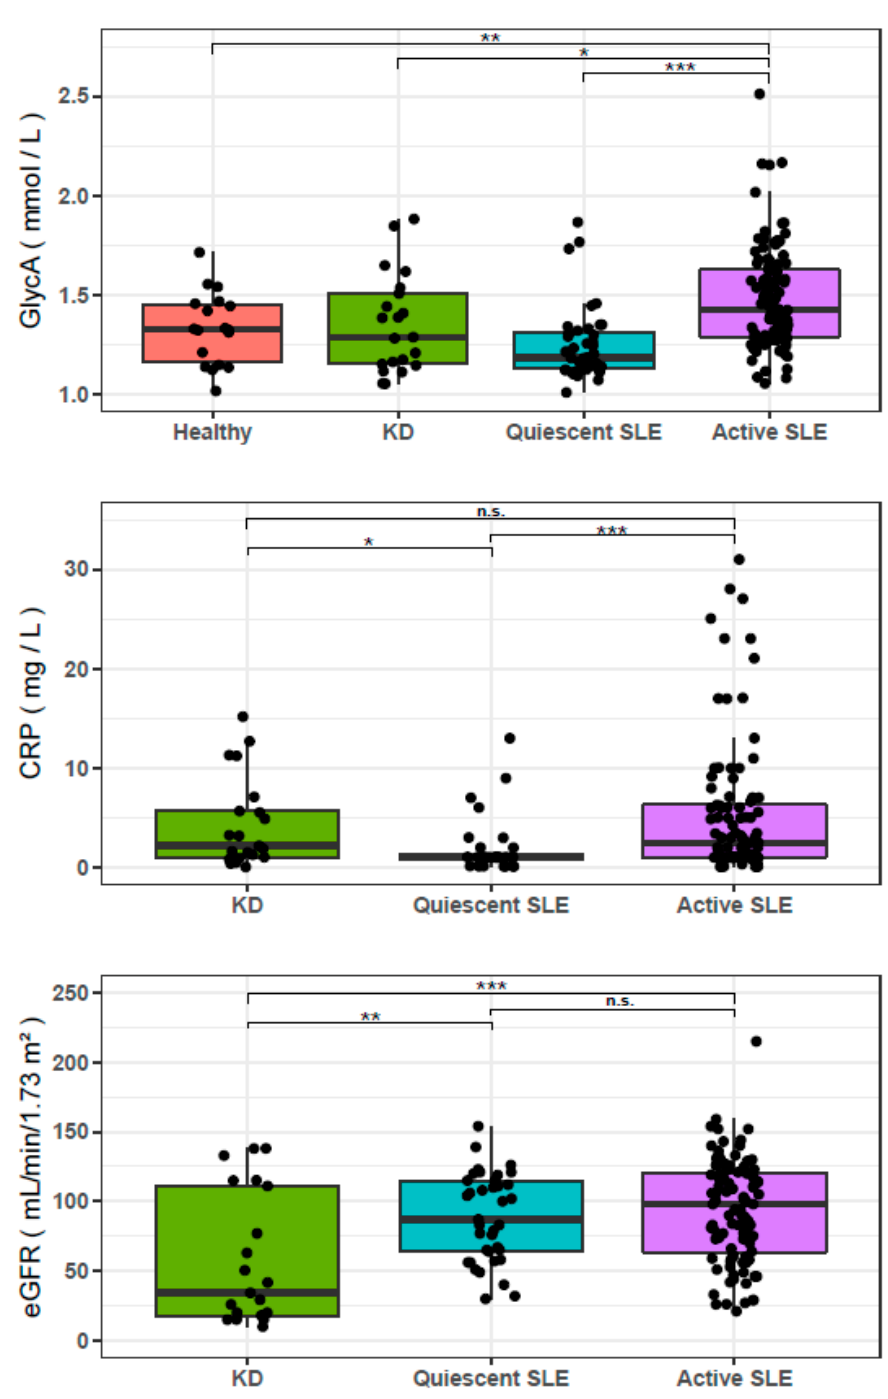
Figure 1. Glycoprotein Acetylation (GlycA), CRP and eGFR of healthy controls, kidney disease controls (KD), quiescent Systemic Lupus Erythematosus (SLE) and active SLE. GlycA is elevated in active SLE ( n = 105), compared to healthy controls ( n = 20), KD controls ( n = 21), and quiescent SLE ( n = 39) patients. CRP level is lower in quiescent SLE than in active SLE and KD controls but does not di ff er between active SLE and KD controls. Estimated glomerular filtration rate (eGFR) is lower in KD controls than in patients with quiescent or active SLE, thereby preventing decreased renal function from being the sole cause of the elevation of GlycA in active SLE. Significance of a Mann-Whiney-Wilcoxon test comparing the groups are indicated (* p < 0.05, ** p < 0.01, *** p < 0.001).